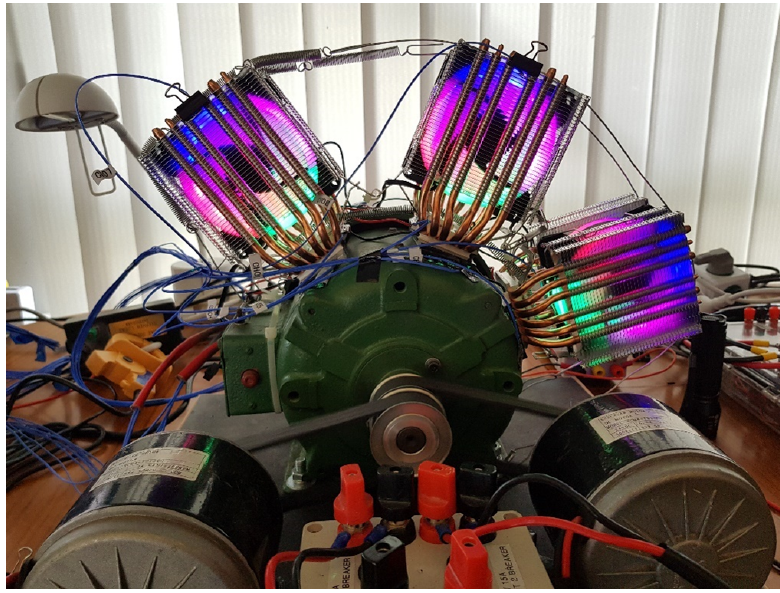
Figure 12. The setup of the heating of the test motor with the TECs and heat pipe